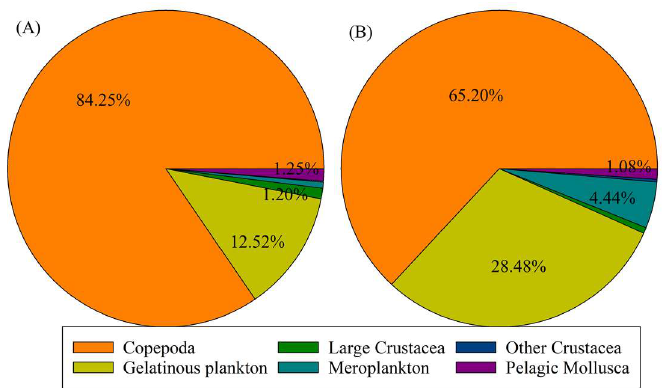
Figure 3. The proportion of functional taxa among mesozooplankton communities collected during the cruises in June 2018 ( A ), and June 2019 ( B ).